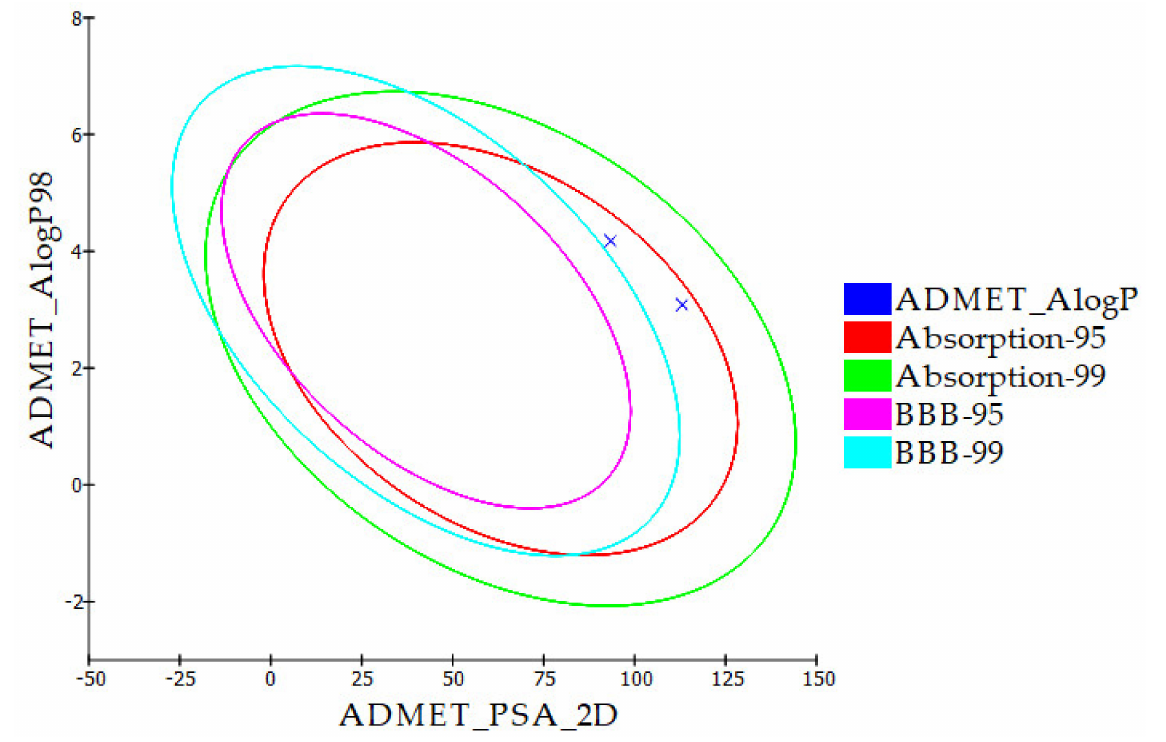
Figure 14. ADMET calculations of compound 10 and sorafenib.